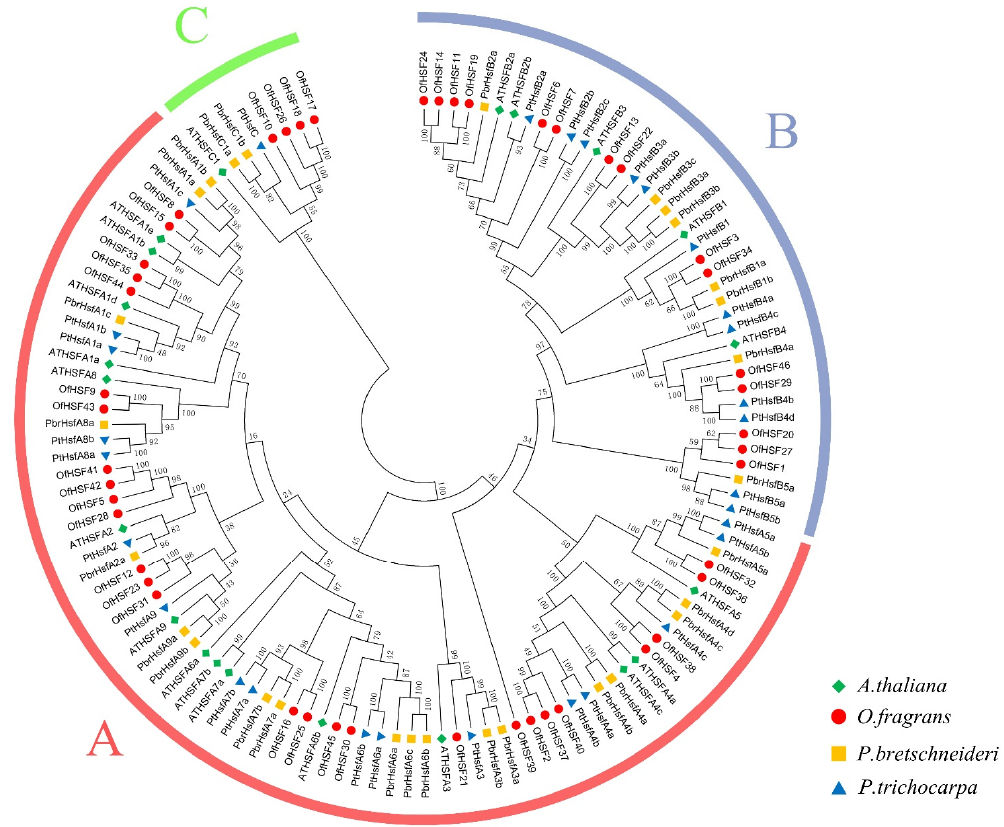
Figure 1. Phylogenetic tree of HSF family members from O. fragrans (Of), A. thaliana (At), P. bretschneideri (Pb) and P. trichocarpa (Pt). Phylogenetic relationships were constructed using MEGA11 with the Neighbor-joining method. The OfHSF s were divided into A, B and C subfamilies and represented by with different colors.